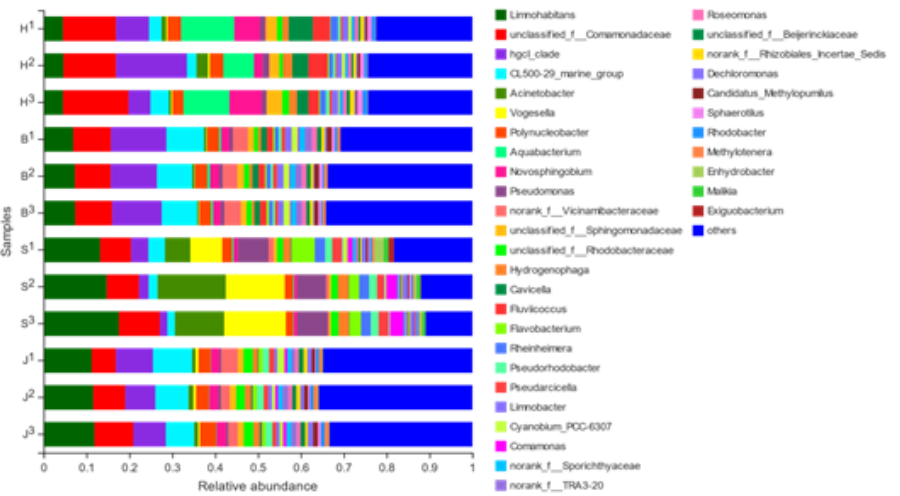
Figure 4. Analysis of the bacterial colony structure at the genus level of the four groups. (H represents the Hechuan District, S represents the Shapingba District, J represents the Jiangbei District, and B represents the Beibei District).